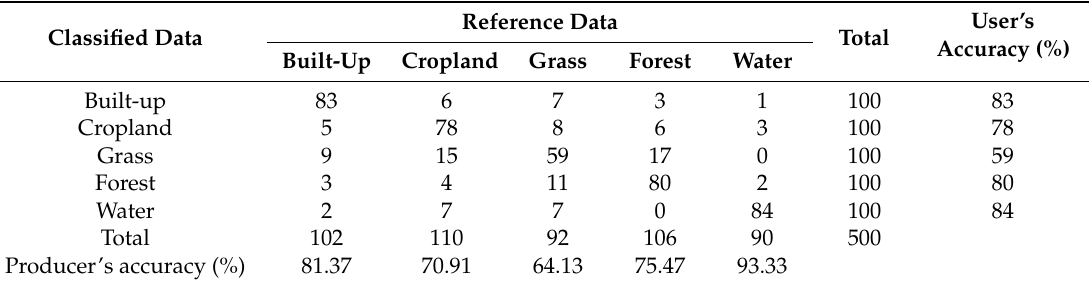
Table A3. Error matrix for the classified 2015 LULC map.